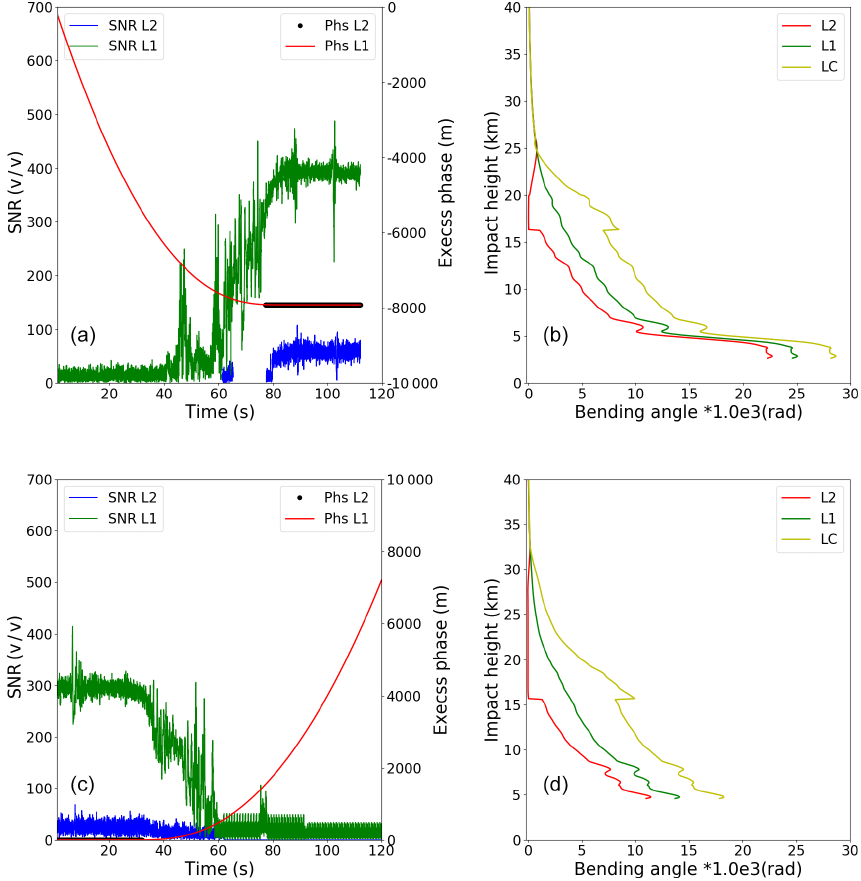
Figure 3. Two bad cases – (a) a rising profile (FY3C_GNOSX_GBAL_L1_20170128_0332_AEG15_MS.NC) and (b) a setting profile (FY3C_GNOSX_GBAL_L1_20170128_0850_AEG18_MS.NC). Example L1 (red) and L2 (black) SNR and excess phase measured data. The resulting L1 bending angle (green), L2 bending angle (red) and corrected LC bending angle (yellow) profiles as a function of impact parameter computed using ropp_pp